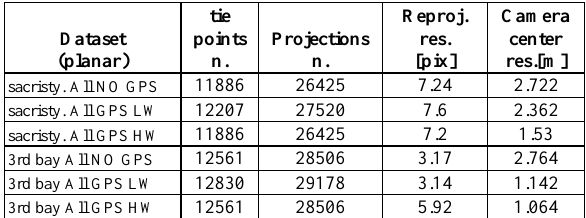
Table 9. Planar dataset: stats on collinearity residuals.